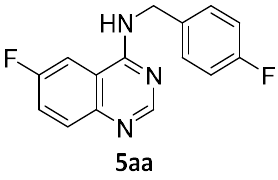
Figure 2. Chemical structure of Spautin-1 ( 5aa ).